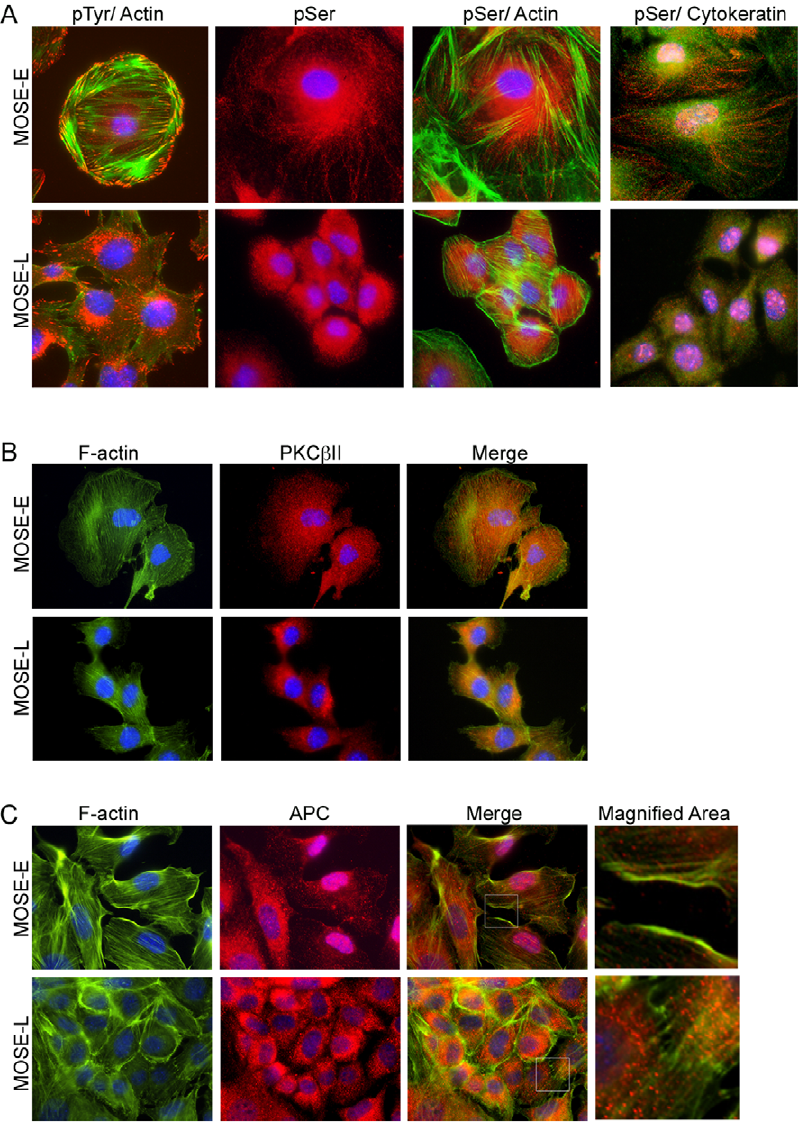
Figure 5. Influence of actin disorganization on localization of signaling proteins PKC b II and APC. ( A ) Immunofluorescent staining for DAPI (blue), phosphotyrosine (red, pTyr), and phalloidin (green, f-actin) or DAPI (blue), phosphoserine (red, pSer), with either phalloidin (f-actin, green) or cytokeratin (green). ( B and C ) Triple staining of MOSE-E and -L cells with DAPI (blue), phalloidin (f-actin, green) and PKC b II (red, B) or APC (red, C ) antibodies. (Original magnification